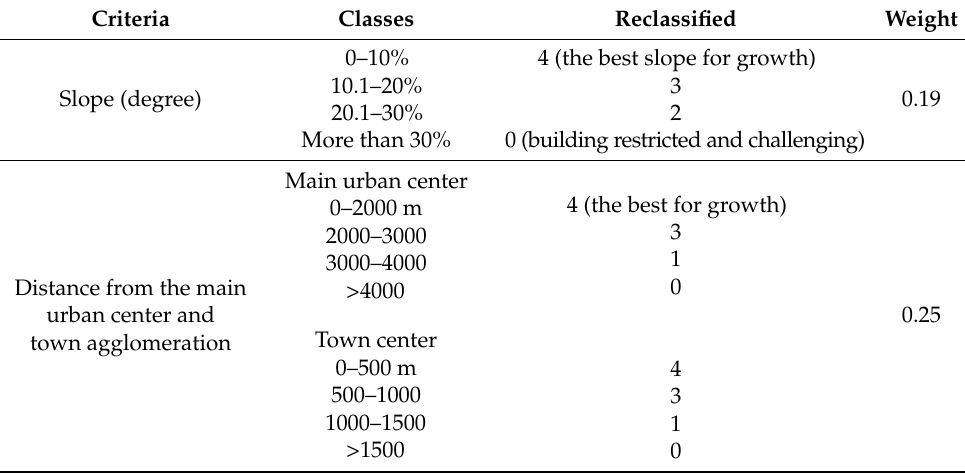
Table 3. Criteria reclassification and